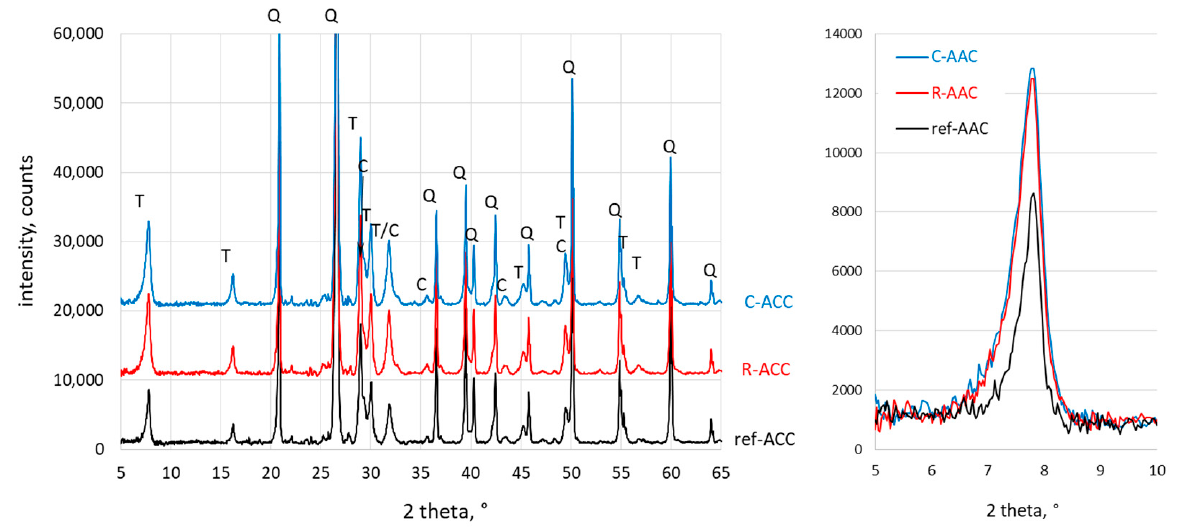
Figure 6. XRD pattern of AAC samples (T—1.1 nm tobermorite, Q—quartz, C—C–S–H phase). On the right, a comparison of the main tobermorite peaks for investigated concretes is plotted.